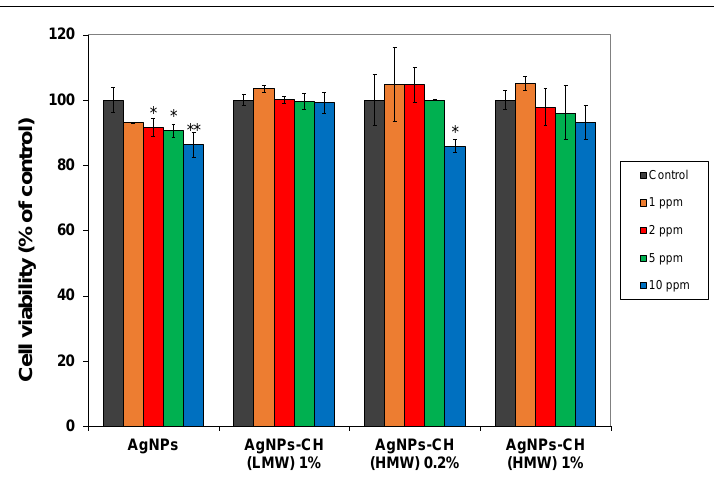
Figure 5. The viability of the CCD-1070 Sk cells treated with different concentrations of AgNPs after 24 h. The values are the means of the results for each sample from three separate experiments. Error bars indicate standard errors of the means. The statistical significance is indicated as follows: * p < 0.05.